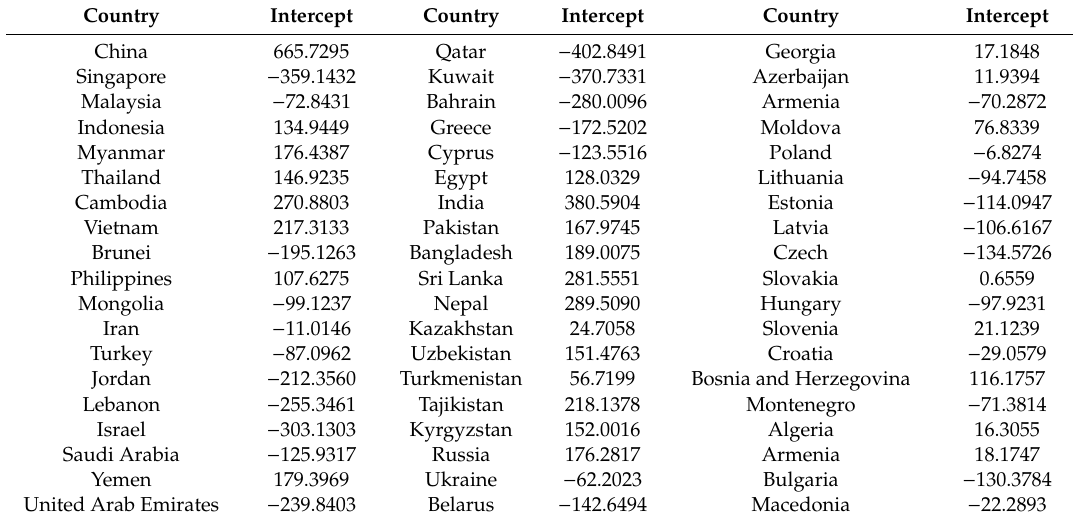
Table 8. Fixed e ff ects (cross) intercept